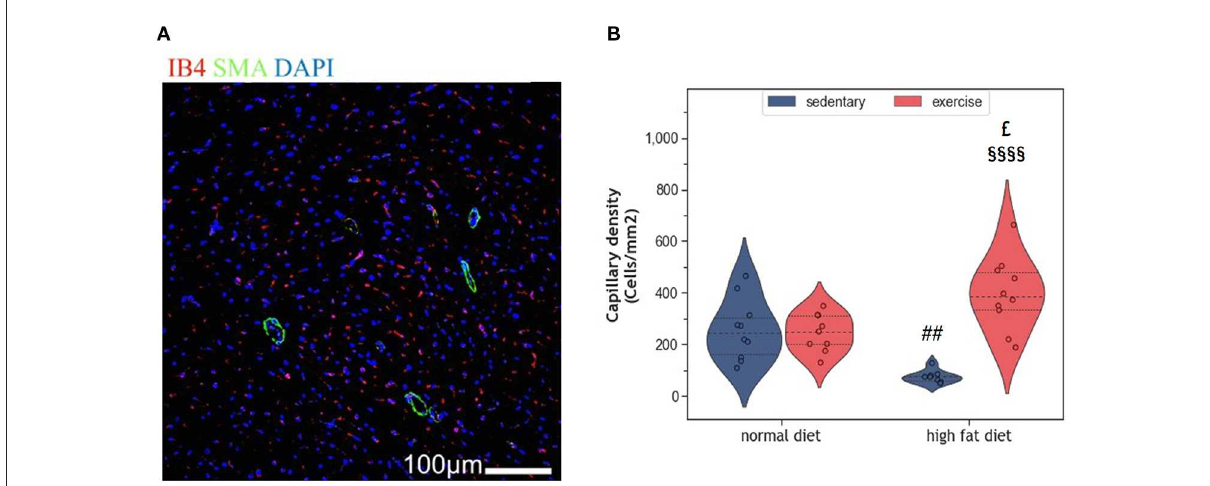
FIGURE5 (A) Representative histological images of the left ventricle showing capillary density. The sections have been stained with anti-isolectin B4 (ILEB4), anti-Smooth Muscle alpha-Actin (SMA) antibodies and DAPI. (B) Violin plot showing the change in capillary density of the left ventricles of HFD groups. From each experimental group 10 animals were selected for histomorphometry analysis. Statistical differences between groups were calculated with the two-way ANOVA with Sidak post-hoc tests for multiple comparisons. p -values are only shown for pre-specified group comparisons. ## p < 0.01 compared to the sedentary normal diet group; £ p = 0.025 compared to the exercise normal diet group; §§§§ p < 0.00001 compared to the sedentary high fat diet